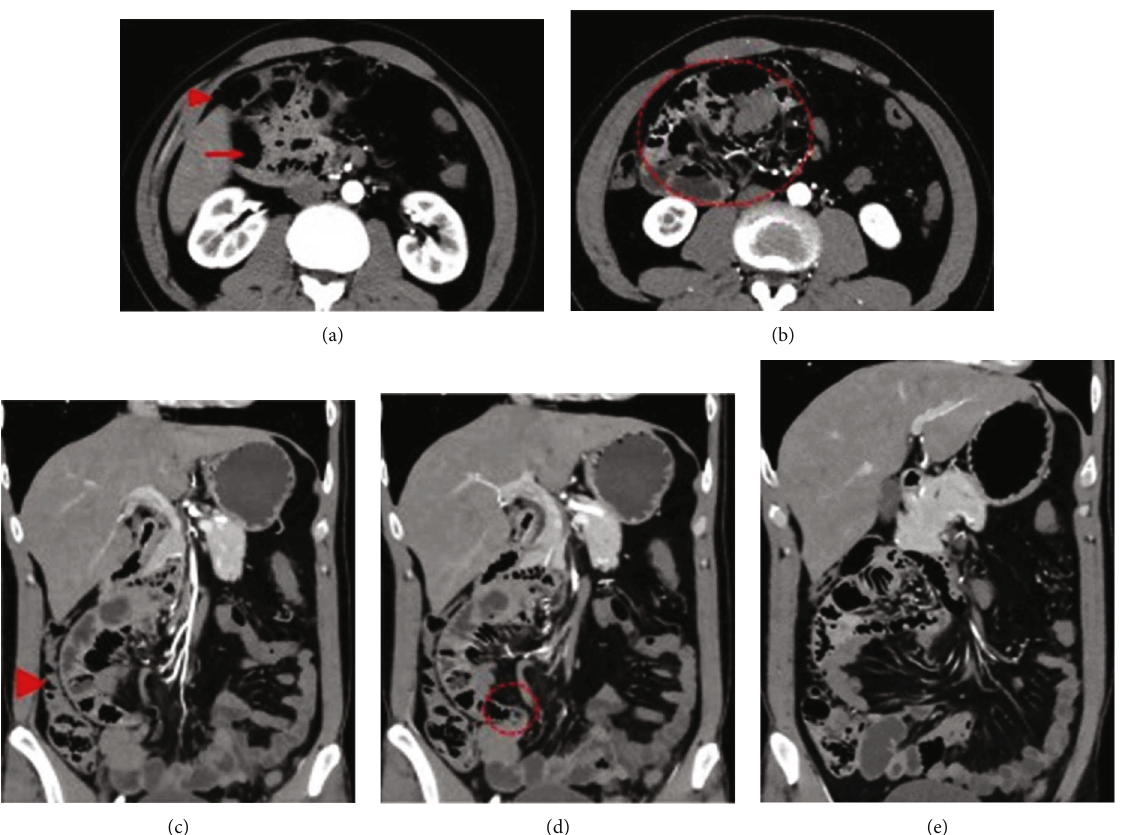
Figure 1: CT scan in Case 1. (a) There was no duodenal horizontal section. The duodenal descending section and jejunum (arrow) were located under the ascending colon (arrowhead). (b) The jejunum (dotted area) was located in the right upper quadrant. (c) The ascending colon (arrowhead) was recognized at the normal position. (d) The part where the jejunum excluded to the retroperitoneal side comes out into the abdominal cavity was narrowed like a “ hernia defect ” (dotted area). (e) The small intestine that emerges into the abdominal cavity runs to the left and then reached the ileocecal region.